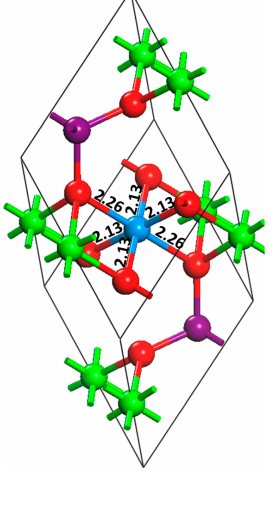
Figure 4. Atomic model showing the primitive cell for U 6+ incorporated magnetite (Fe UO ). Uranium has replaced a Fe 3+ in an octahedral site and a second Fe 3+ octahedral site 4 8 is now vacant to balance charge. Bond distances (in Angstroms) for the first U-O sphere are indicated. Colors for the atoms are as follows: U 6+ blue, Fe 2+ purple, Fe 3+ green, O 2 −